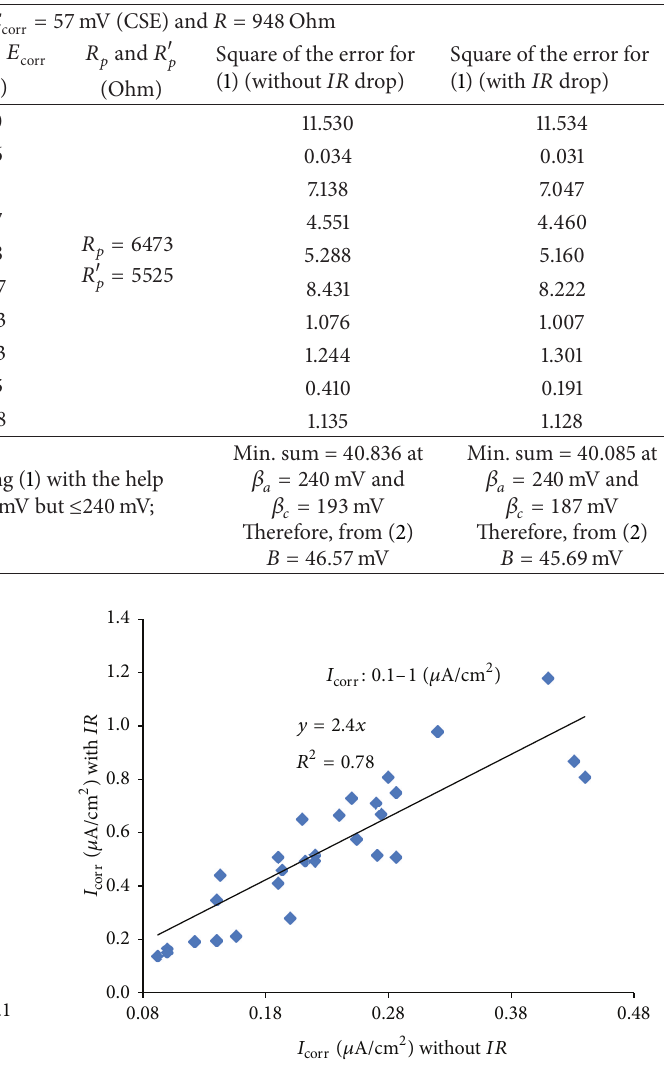
with and without IR compen- corr